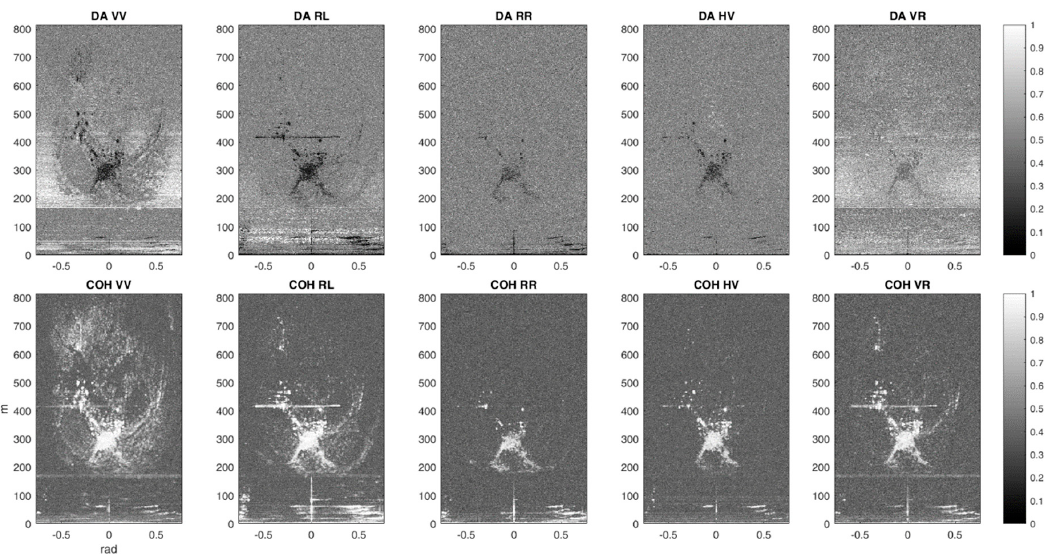
Figure 14. DA and COH for the different combinations analyzed in the short interval images series.